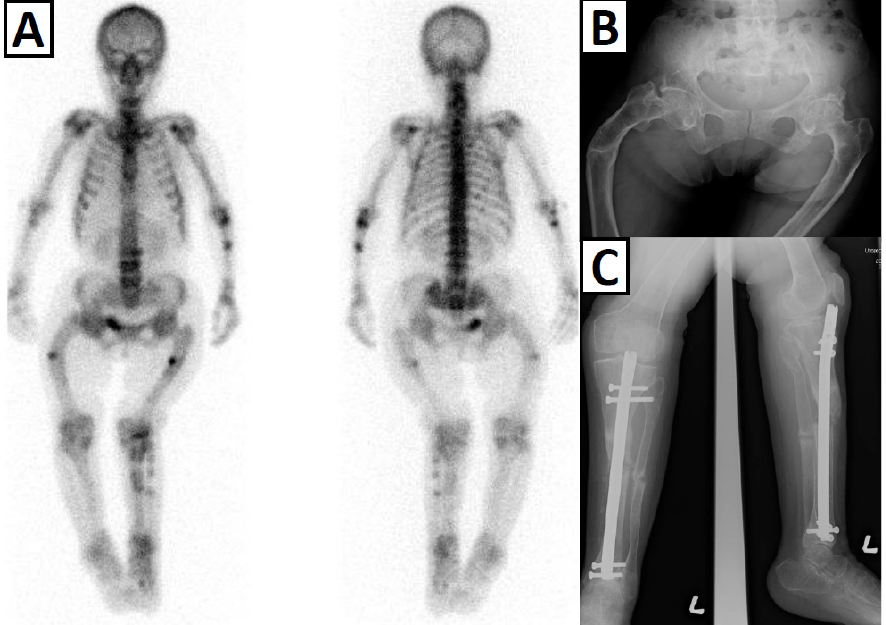
Figure 2. Bone scintigraphy of the patient at age 67 years ( A ). X-rays of both femurs ( B ) and left lower legs ( C ) after intramedullary nail surgery. The accumulations of radioisotope indicated fracture/pseudofracture of the left forearm, lumbar spines, and both legs. Along with bowing, beaking was observed at both femurs, findings consistent with the results of bone scintigraphy. After the surgery, she experienced partial easing of pain in her lower extremities, but calcifications of the pseudofracture regions were delayed.